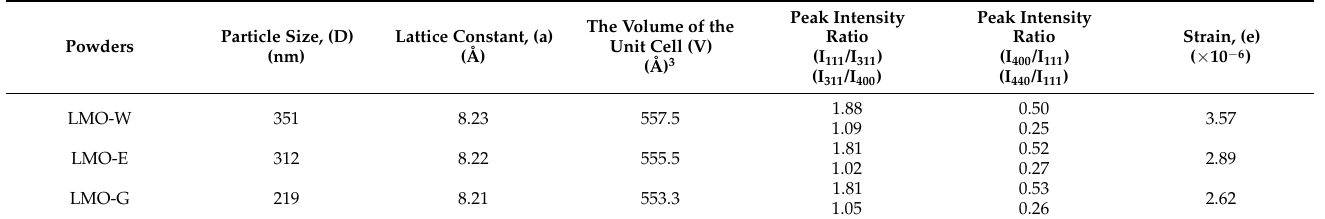
Table 1. Physical parameters for LiMn 2 O 4 materials synthesized using the citric acid-assisted method.